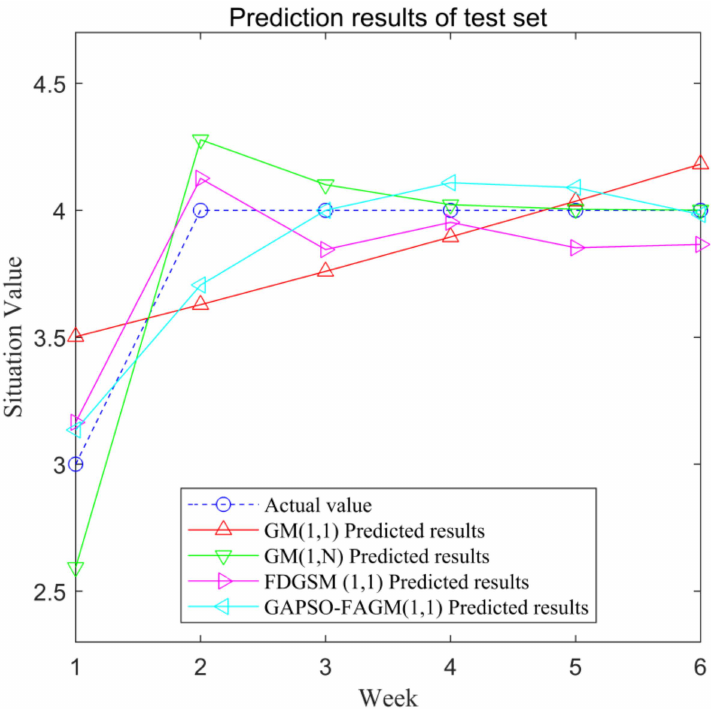
Figure 5. Prediction results of the test